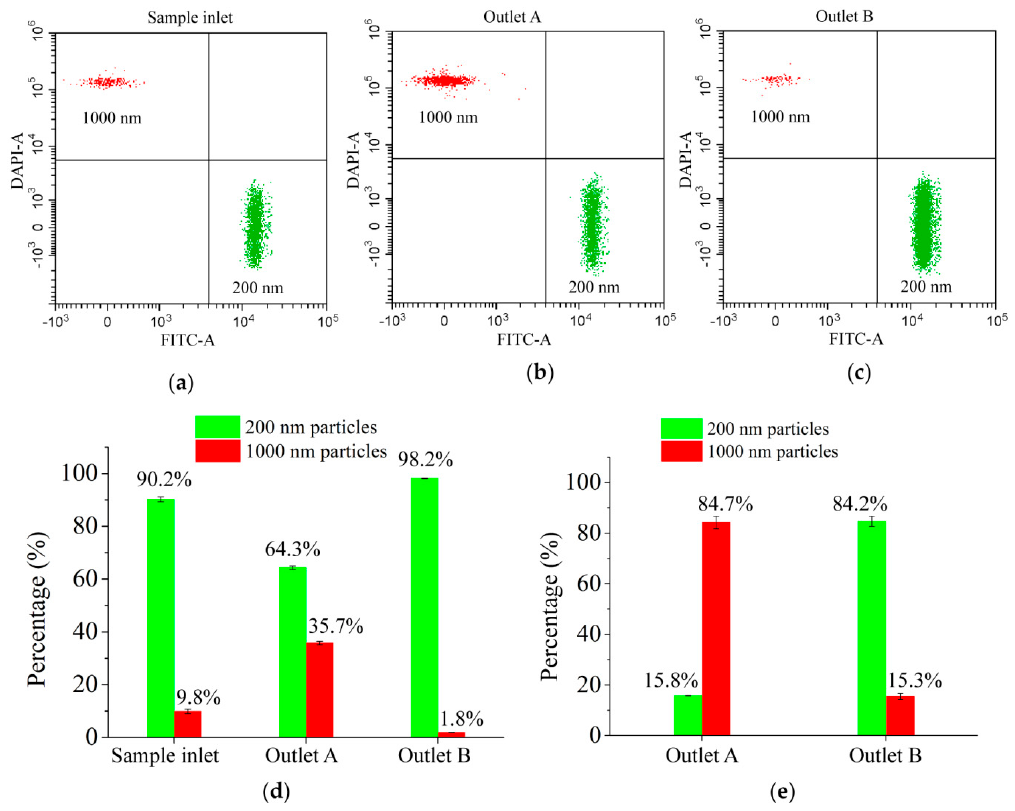
Figure 6. Flow cytometry test results obtained from: ( a ) Sample inlet; ( b ) Outlet A; ( c ) Outlet B; ( d ) The proportion of the two kinds of particles at inlet and outlets; ( e ) The number distribution of the two kinds of particles at both outlets.